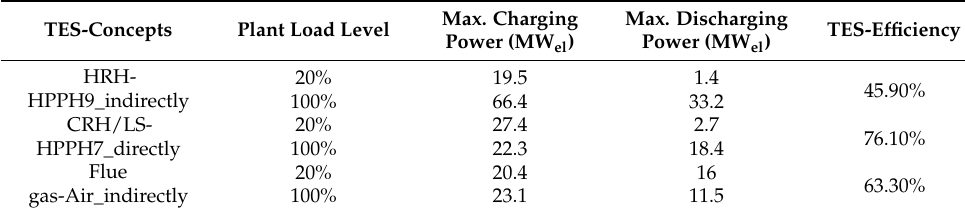
Table 7. Parameters of the lead